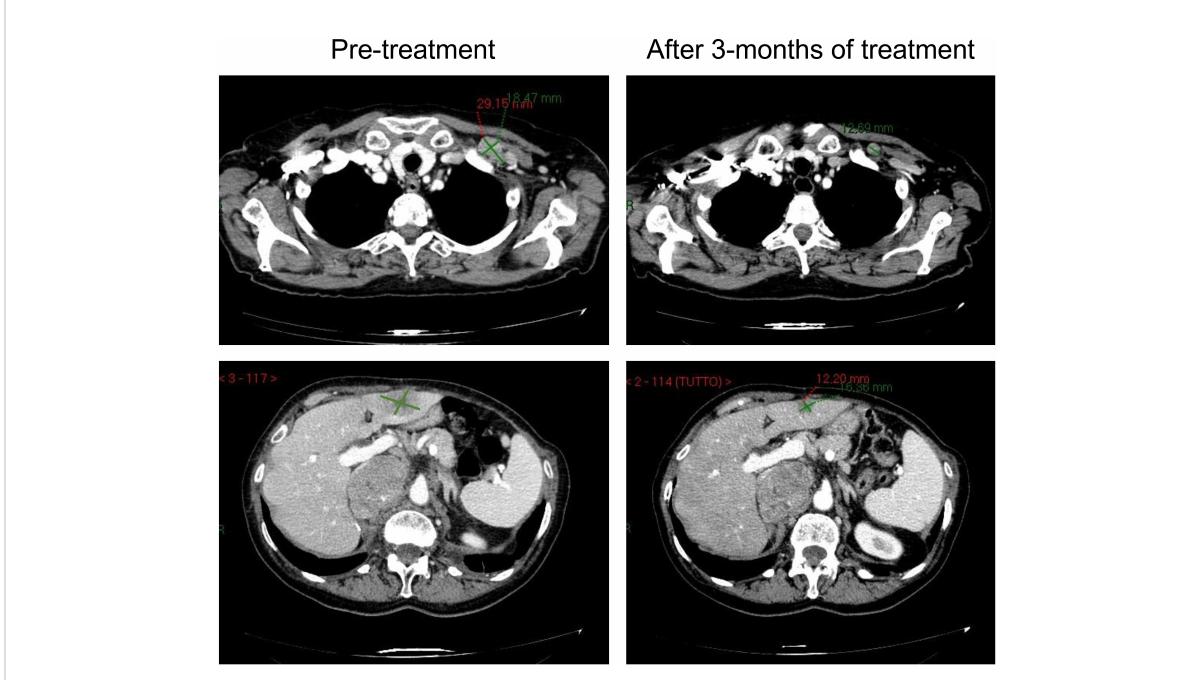
FIGURE 1 An exempli fi cative case of response in the liver and in a nodal